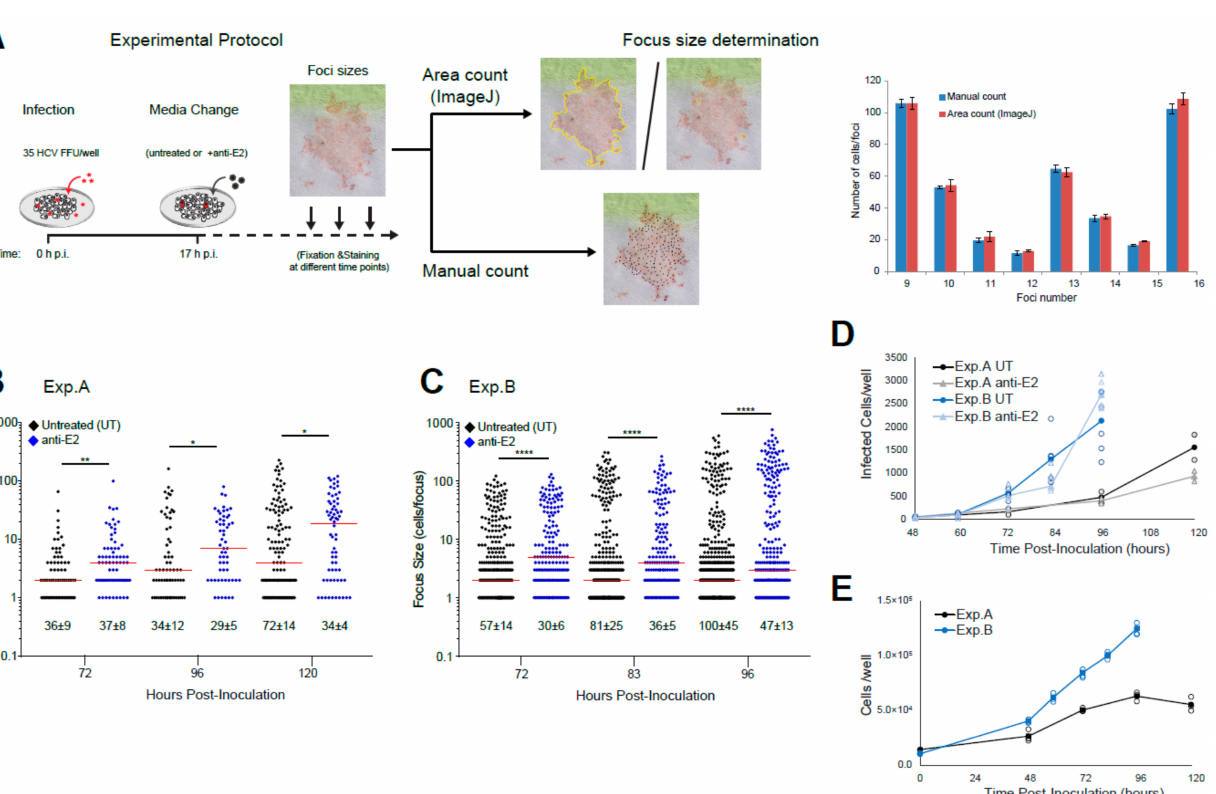
Figure 2. HCV Spread Kinetics: ( A ) Schematic of the experimental protocol: Confluent Huh7 cells were infected with 35 HCV FFU/well. At 17 h p.i. the viral inoculum was removed, and fresh cDMEM was added either in the absence (i.e., untreated) or presence of 10 µ g/mL anti-E2. Monolayers were fixed at different times post-infection and then stained for HCV to detect infected cells. Focus size was counted by individual cell counts for small foci or by area using ImageJ to circle each focus and divide the focus area by the average area of single cells for larger foci. The accuracy of ImageJ focus size calculation was determined by comparing three technical replicates ImageJ area counts with three technical replicate manual counts. The graph shows individual cell counts vs. area counts by ImageJ for representative foci, numbered arbitrarily on the X -axis. ( B ) Representative of early experiments: Duplicate wells fixed at 72, 96, and 120 h p.i. and then stained for HCV with NS5A antibody to detect infected cells. ( C ) Representative of later experiments: Five to six wells were fixed at 72, 83, and 96 h p.i. and stained for HCV with E2 antibody to detect infected cells. The numbers of foci per well were counted and are indicated below the dot plots as average +/ − standard deviation per well. The number of cells/focus was counted and graphed. Red bar: Median focus size. Statistical differences relative to untreated are indicated (*, p < 0.05; **, p < 0.01; ****, p < 0.0001 by Mann–Whitney U-test). Note that foci sizes from individual wells were pooled for the statistical comparison of foci sizes. The results in each panel are representative of two experimental repeats. ( D ) Total number of infected cells per well over time calculated from the data in ( B , C ). Individual well counts (open circles/triangles) and mean (closed circles/triangles). ( E ) Total number of cells per well over time counted in parallel untreated wells for each experiment. Individual (open circles) and mean (closed circles) cell numbers for three wells are